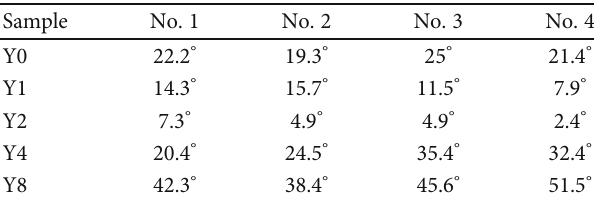
Table 3: Contact angle after slick water soaking for di ff erent times.